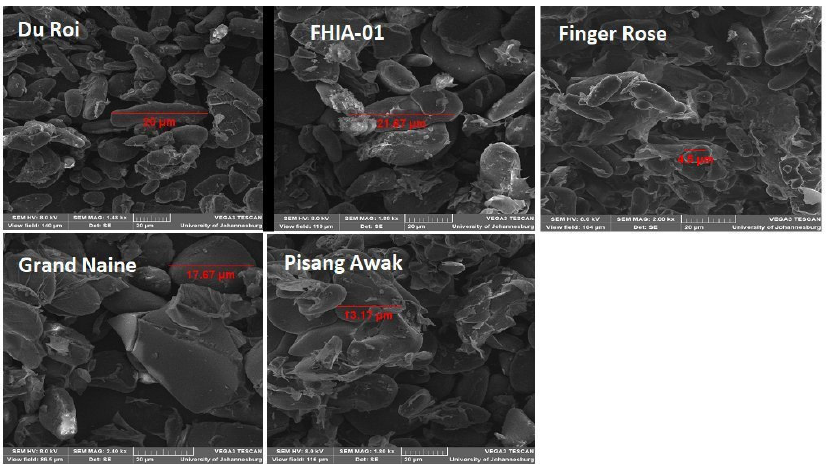
Figure 1. SEM micrographs green banana starch at 2000×